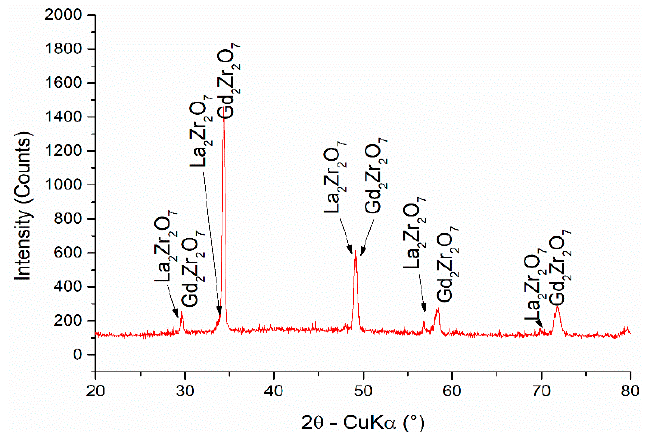
X-ray di ff raction spectrum obtained for Nimonic with 4 layers of material (NiCrAlY / YSZ / LZO / GZO) after heat treatment at 1250 ◦ Figure 8. X-ray diffraction spectrum obtained for Nimonic with 4 layers of material (NiCrAlY/YSZ/LZO/GZO) after heat treatment at 1250 °C.